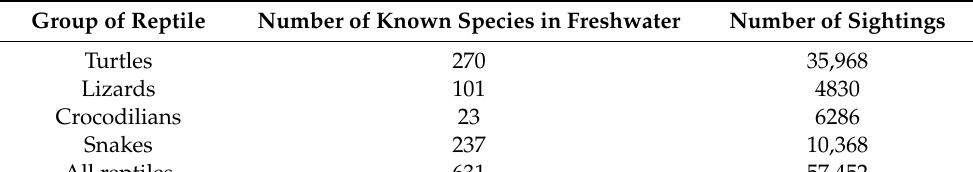
Table 1. The number of species attributed to freshwater in each major group of reptiles and the number of sightings in the Global Biodiversity Information Facility (GBIF) of any species in each group between